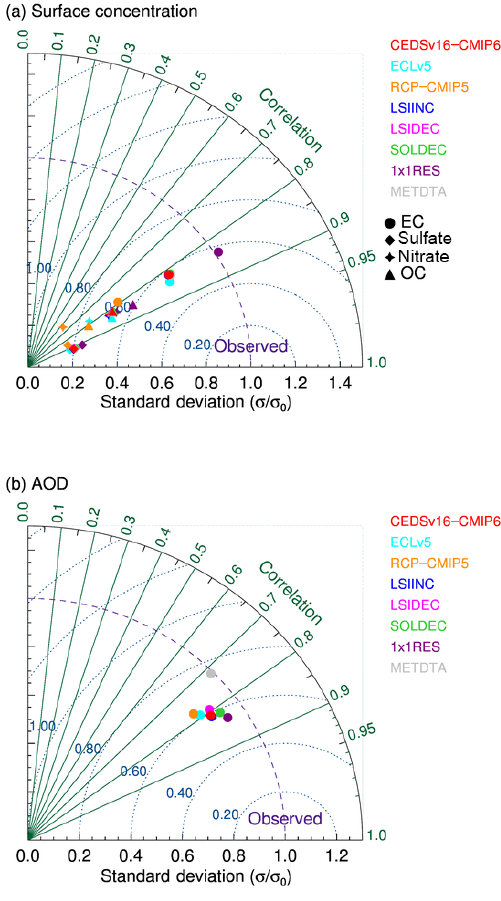
Figure 5. Taylor diagram of modeled and measured aerosol surface concentrations in the baseline simulation and sensitivity tests using all observations in Fig.